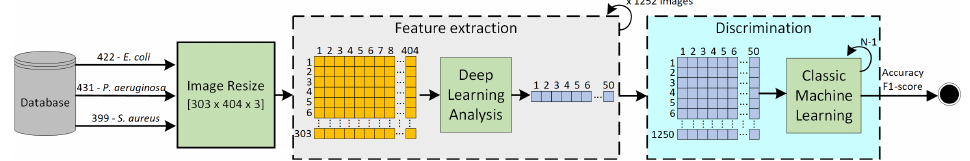
Figure 1. Methodology